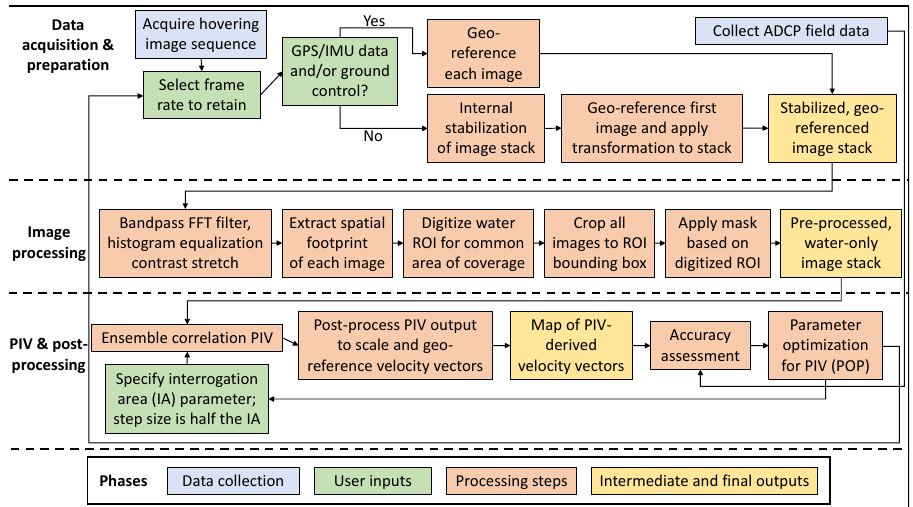
Figure 3. Flow chart outlining the data, user inputs, processing steps, and outputs of the particle image velocimetry (PIV) workflow.